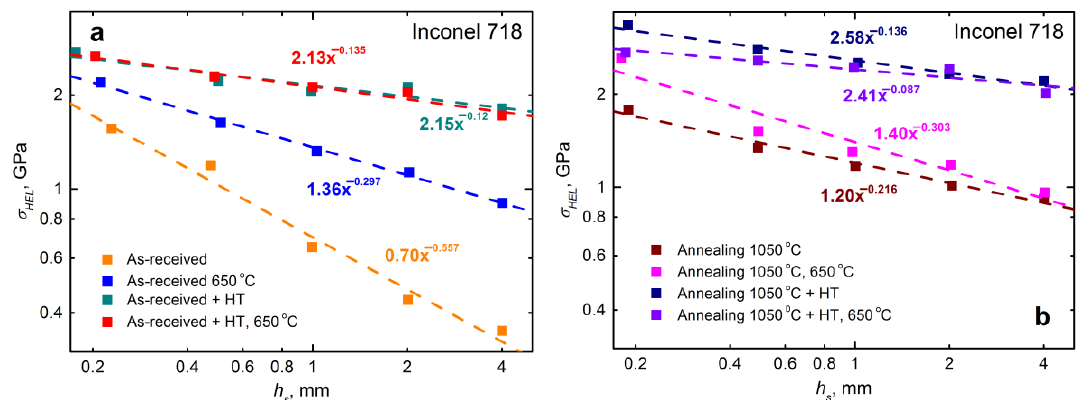
Figure 6. The effect of temperature on the Hugoniot elastic limit and the process of decay of the elastic precursor in Inconel 718 superalloy samples (( a ) — as-received state, ( b ) — annealing state) obtained with various heat treatment.